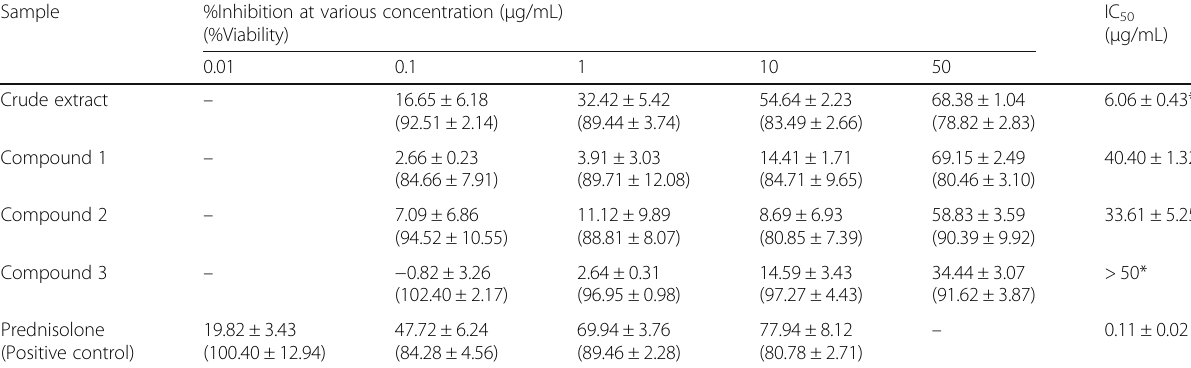
Table 2 Inhibitory effect of isolated compounds on LPS -induced nitric oxide release from RAW 264.7 cell lines Sample